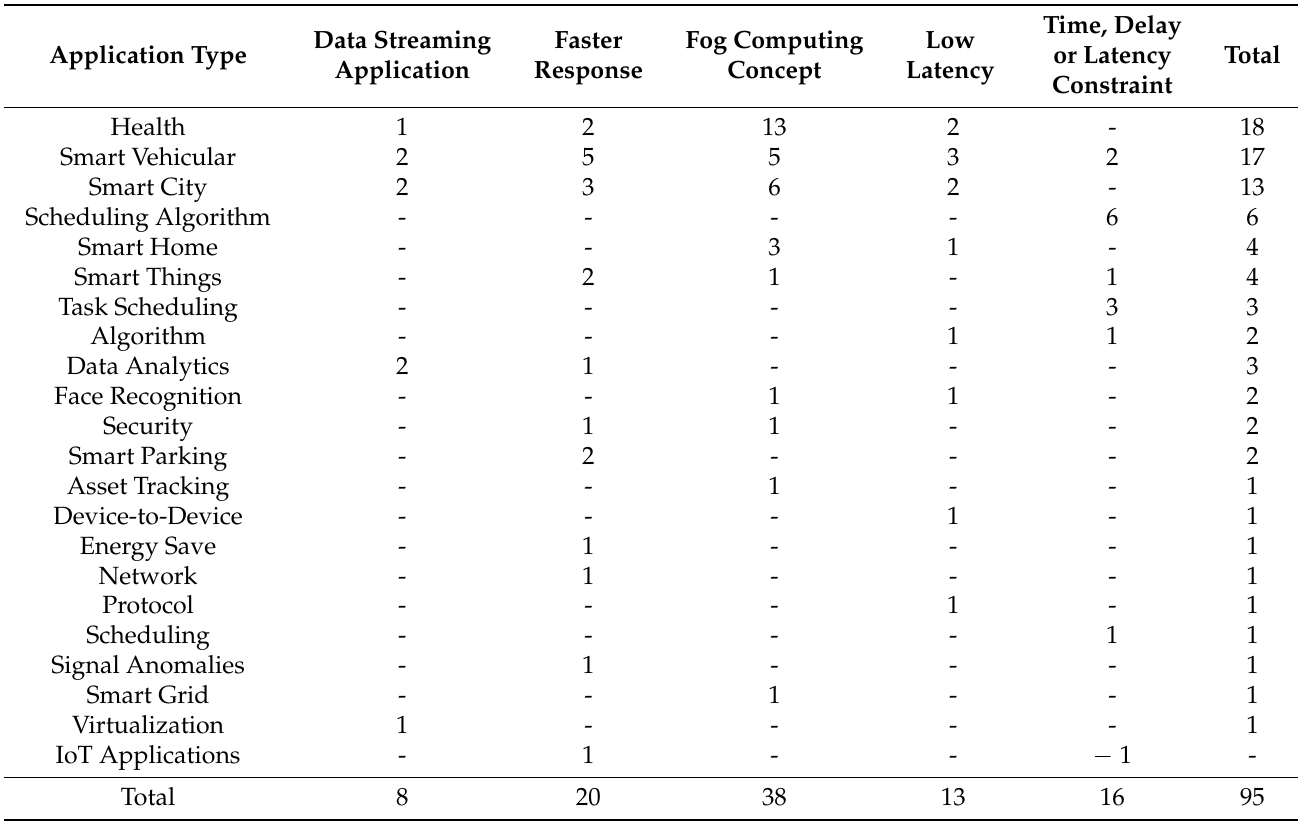
Table 3. Publications separated by application and